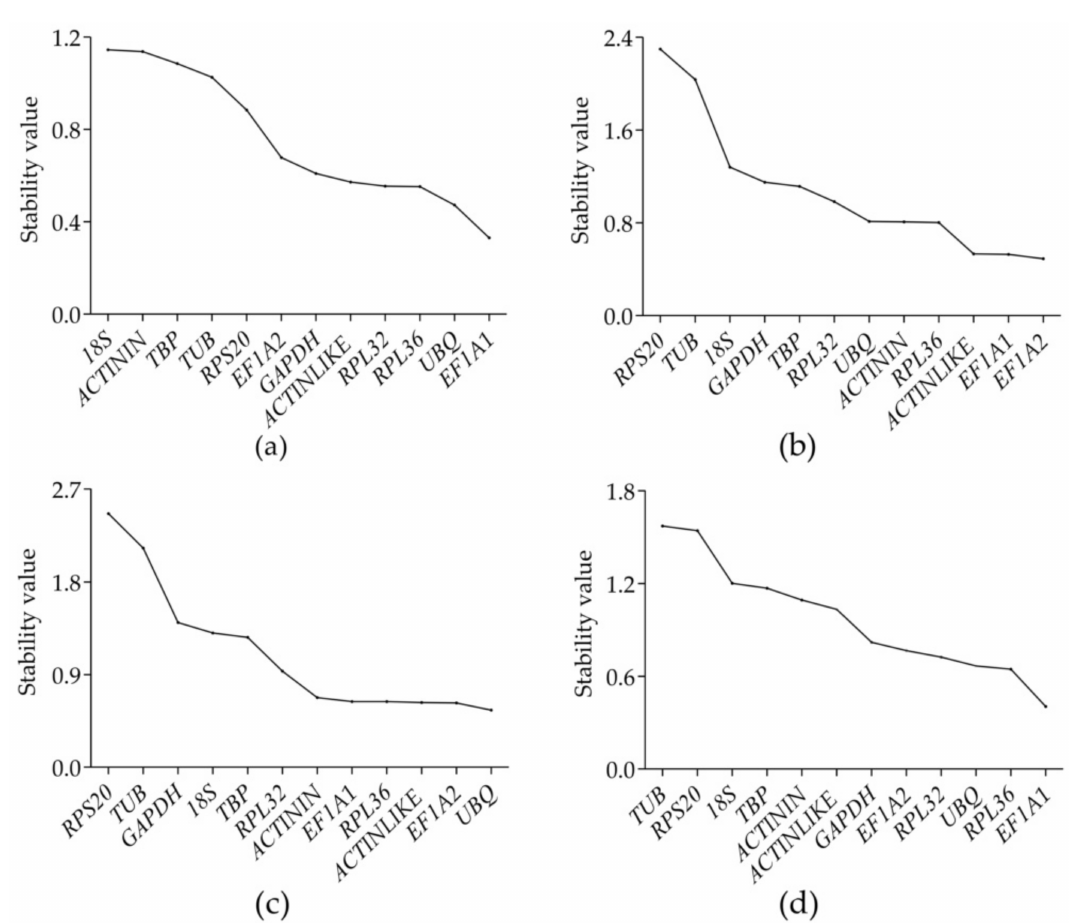
Figure 5. Stability of the expression of the candidate reference genes in Glenea cantor , as calculated by the NormFinder: ( a ) adult tissues; ( b ) developmental stages; ( c ) sexes; and ( d ) all